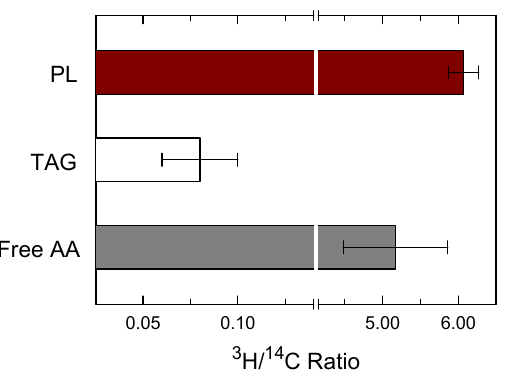
Figure 3. Source of AA release in zymosan-stimulated macrophages. The cells, labeled with [ 3 H]AA and [ 14 C]AA were treated with 0.5 mg/mL zymosan for 1 h. Afterward, the 3 H/ 14 C ratios of extracellularly liberated free AA, PL and TAG were calculated. The data are expressed as mean values ± S.E.M. ( n = 6).